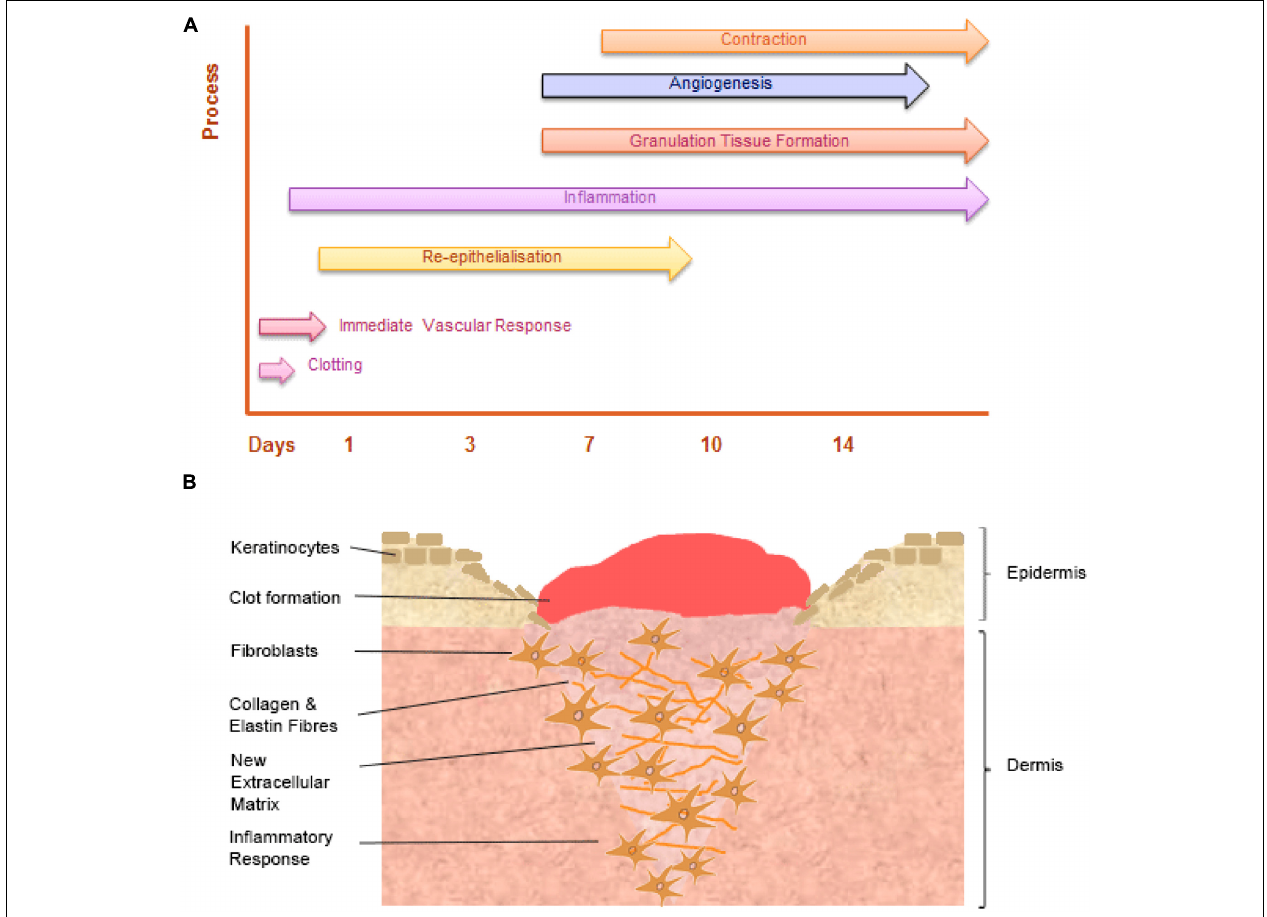
FIGURE 3 |The temporal stages of cutaneous wound healing and key cell types involved. (A) Graph illustrating the key temporal stages of wound healing over the 14 days post injury. (B) The key cell types involved in the wound healing process.